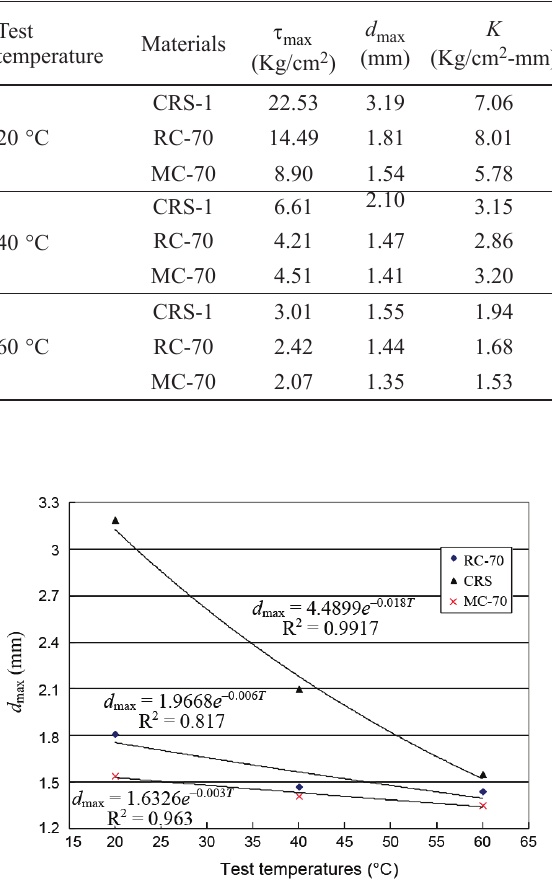
Fig. 5. Shear displacement and temperature